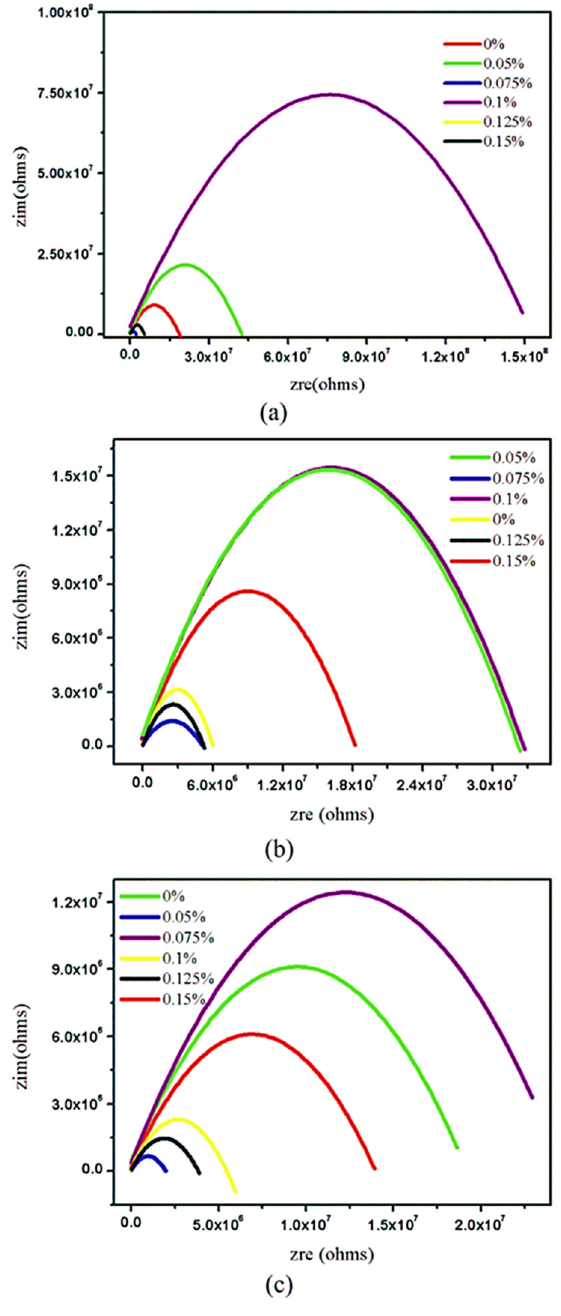
Figure 3. EIS of coatings after immersion in 3.5% NaCl solution for different duration: ( a ) 5 days; ( b ) 16 days; ( c ) 26 days [70]. Reproduced with permission from Wiley.